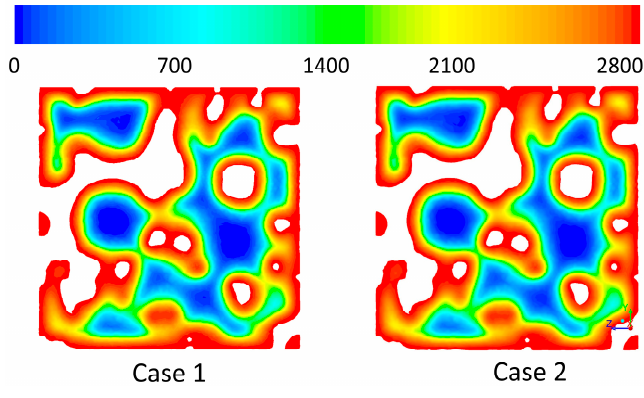
3 · s)) on a cross-sectional plane, x = Figure 7. Reaction rates (mol/(m 3 ·s)) on a cross-sectional plane, x = 0. Figure 7. Reaction rates (mol/(m 3 ·s)) on a cross-sectional plane, x = 0. Figure 7. Reaction rates (mol/(m